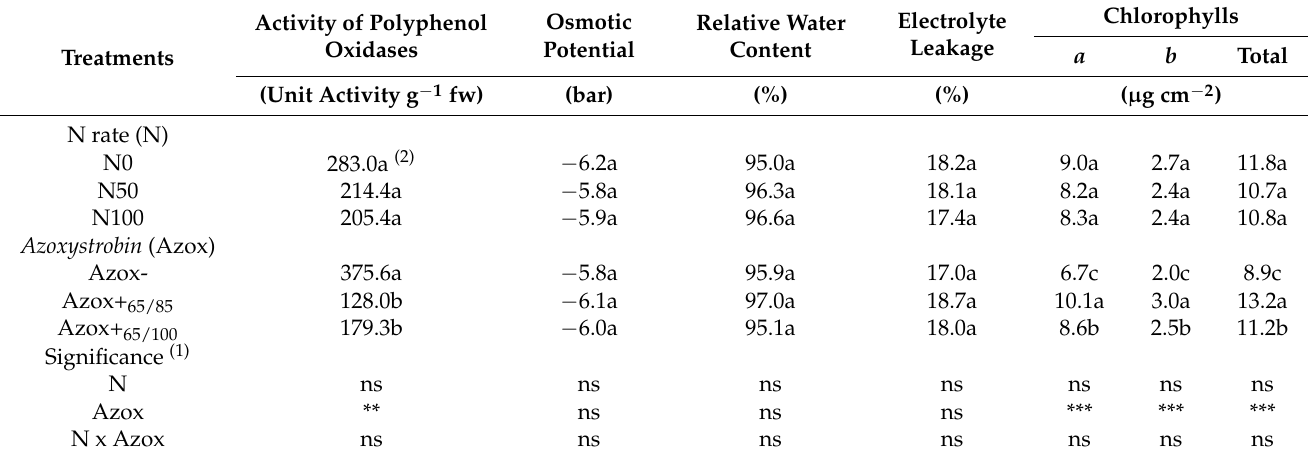
Table 2. Effect of N rate supply and azoxystrobin application on bio-physiological traits of butterhead lettuce at